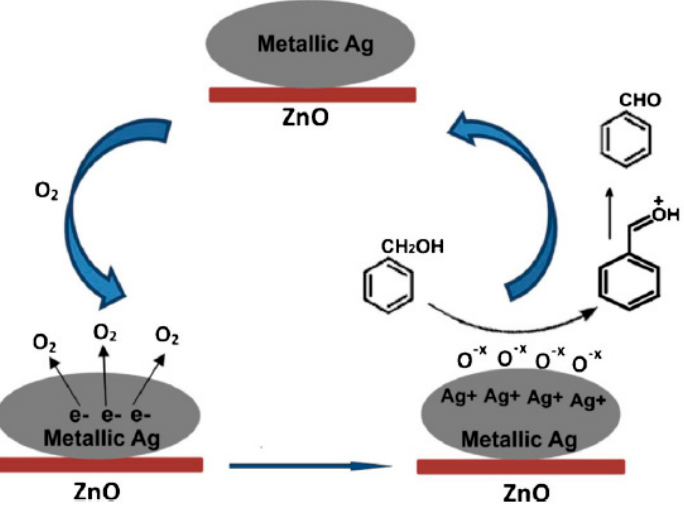
Figure 17. Schematic reaction mechanism of benzyl alcohol oxidation over Ag/ZnO nanocomposite. Reprinted with permission from reference [135]. Copyright 2015 Hindawi publishers.